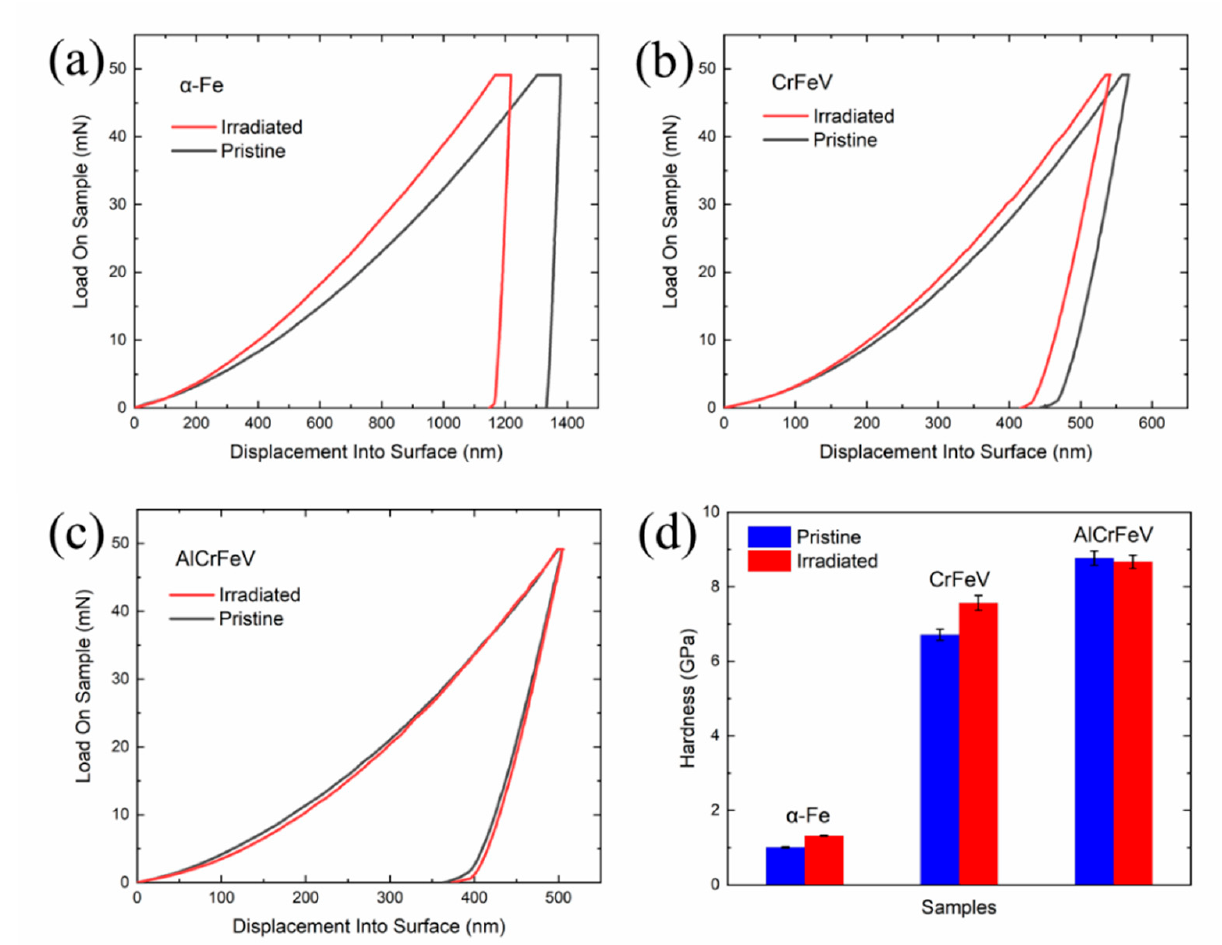
Figure 4. Representative load–unload curves of: ( a ) irradiated and pristine α -Fe; ( b ) CrFeV; and ( c ) AlCrFeV. ( d ) Comparison of hardness.